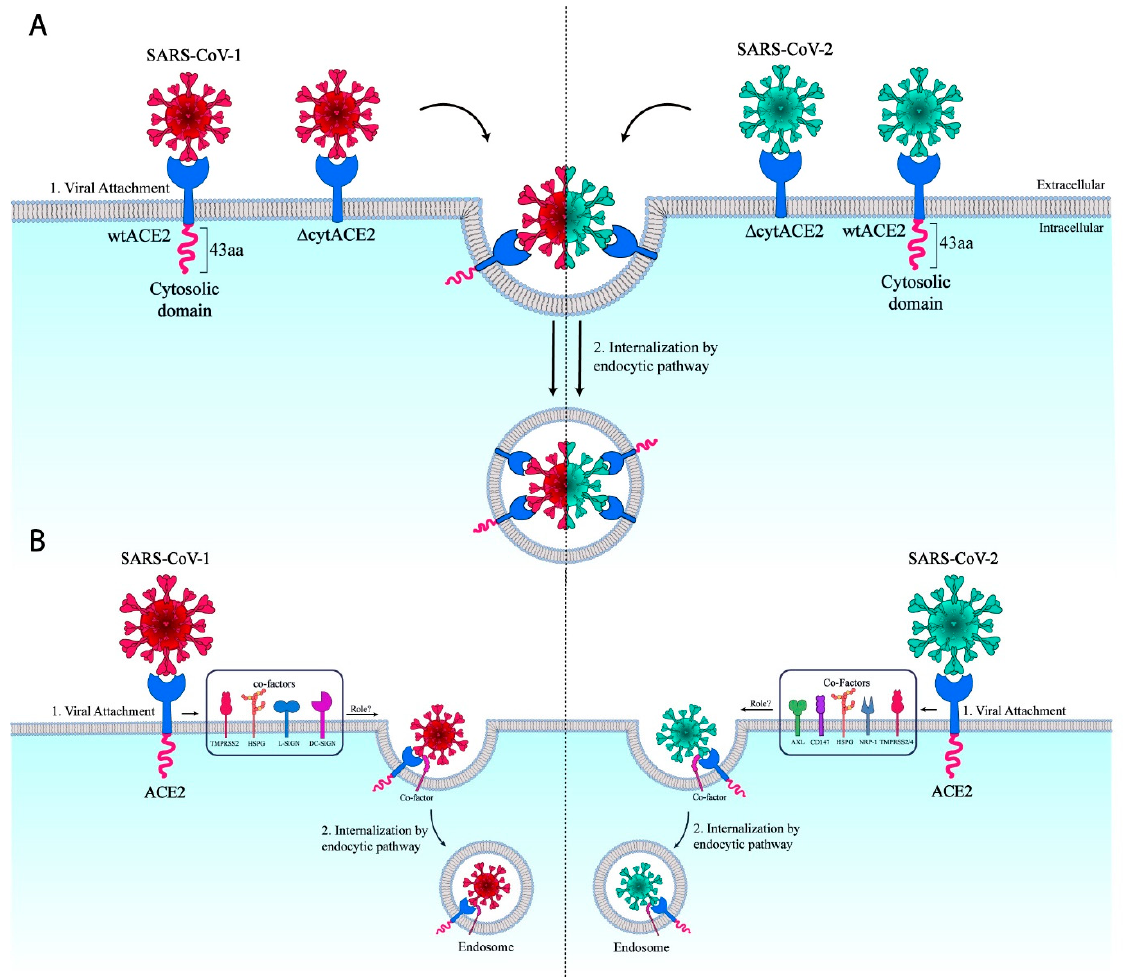
Figure 8. Schematic representation of ∆ cytACE2-mediated entry of SARS-CoVs. ( A ) ACE2 cytoplasmic domain signaling independent internalization of SARS-CoV-1 and -2 into the cells. ( B ) Representation of co-factor/s which might be involved in the entry of SARS-CoV-1 and -2.